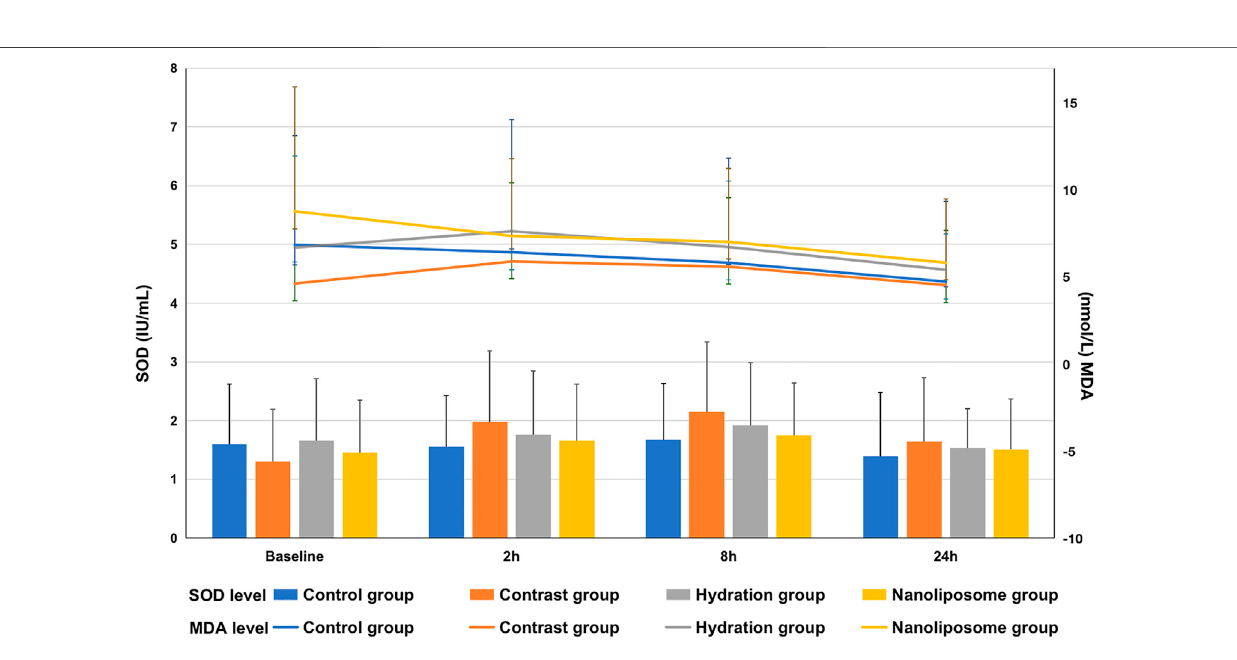
FIGURE 6 | The contents of oxidative stress index SOD and MDA in four groups were detected by ELISA. SOD (cid:2) superoxide dismutase; MDA (cid:2) malondialdehyde. Values are expressed as mean ± SD. *Compared with the contrast group, p < 0.05. **Compared with the contrast group, p < 0.01. # Compared with the hydration group, p < 0.05. ## Compared with the hydration group, p <